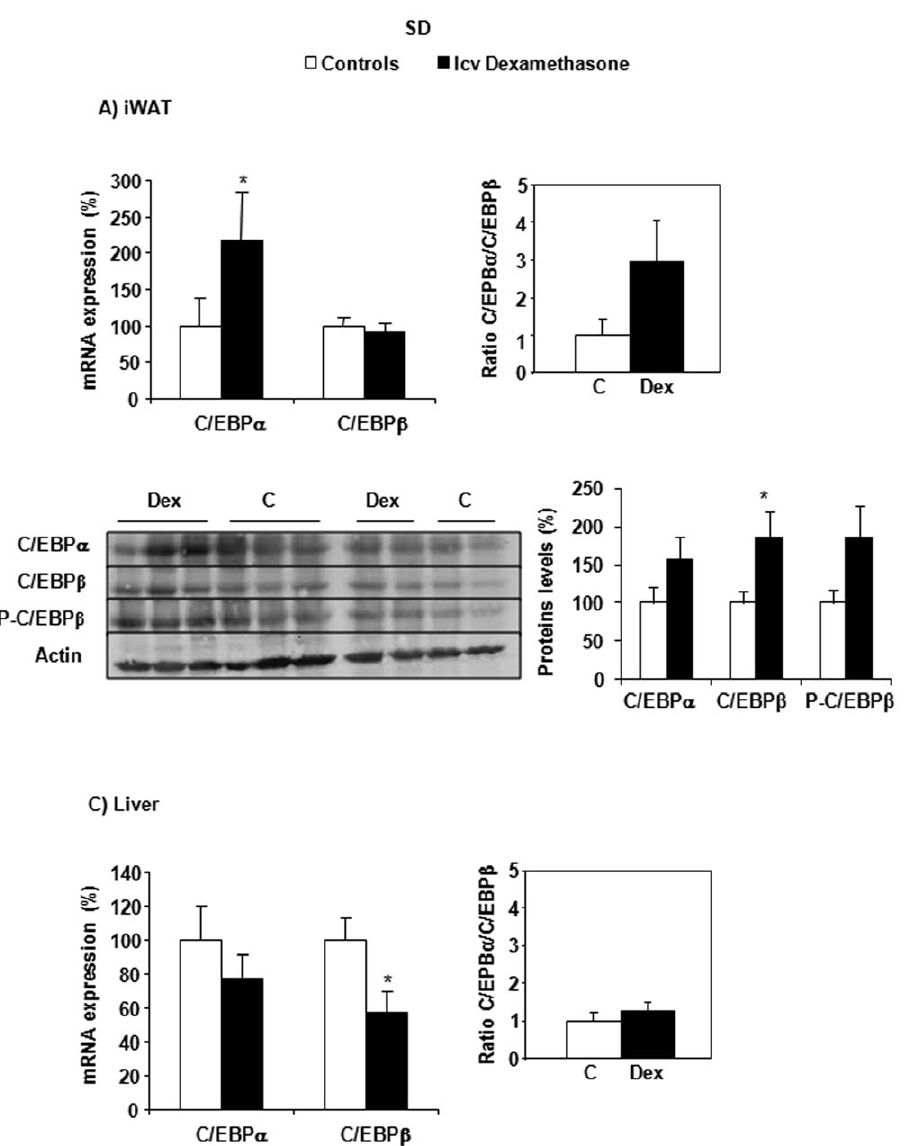
Figure 6. C/EBP a , C/EBP b mRNA and protein expression in iWAT (A) and in the liver (C) of SD rats. Effects of central (icv) dexamethasone infusion for 2 days. A and C) Results are expressed as percent of relative mRNA expression compared to that obtained in control rats (100%). The analysis was performed in duplicate and the results were normalized with RPS29, b -actin and GAPDH expression. Mean 6 SEM of n =7–8 rats per group. B) Representative Western blots of C/EBP a , C/EBP b and phosphorylated C/EBP b -ser 105 (n=5 per group). Quantification was performed using the ChemiDoc TM XRS and the Quantity One TM software. * P , 0.05 compared to vehicle-infused control rats (Student’s t test).